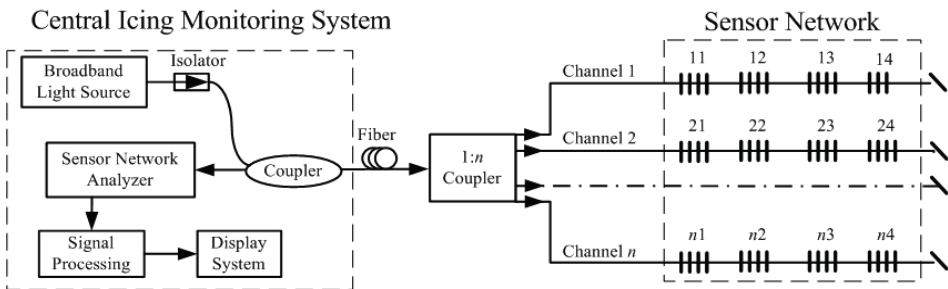
Figure 2. Block diagram of the icing monitoring